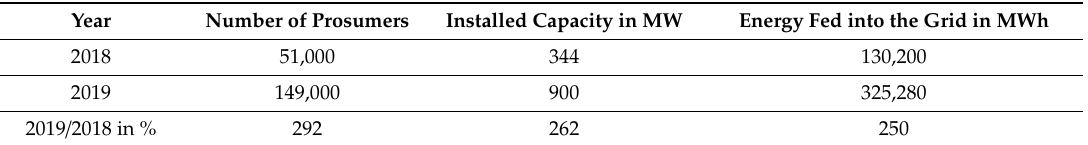
Development of electricity production in the prosumer system using photovoltaic micro-installations in 2018–2019